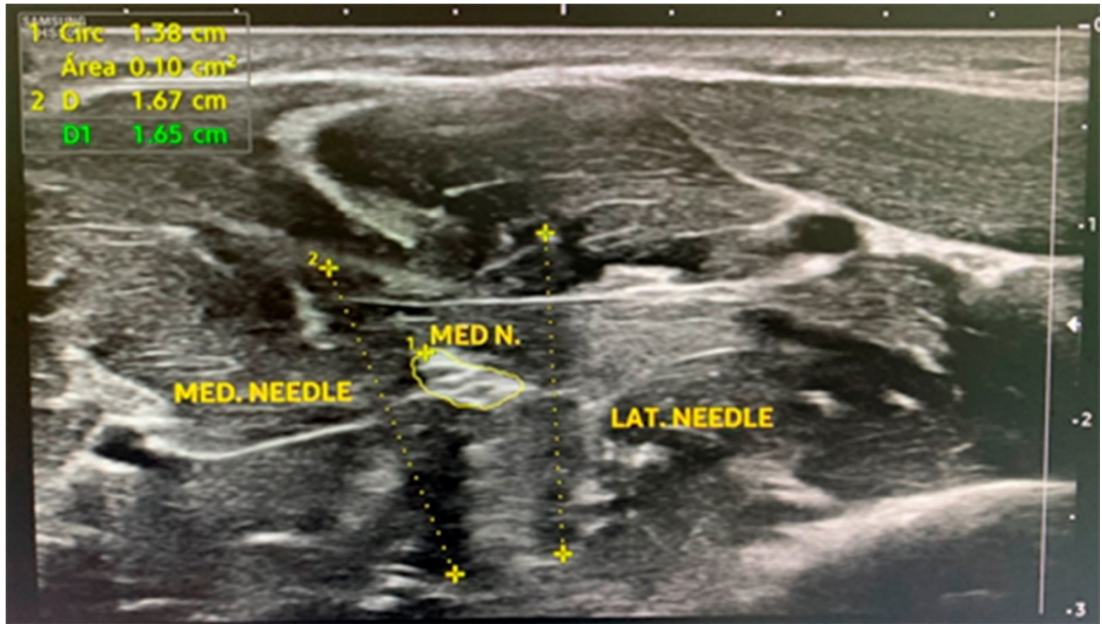
Figure 1. A short-axis approach to the median nerve with two acupuncture needles. MED N.: median nerve; MED NEEDLE: medial needle; LAT NEEDLE: lateral